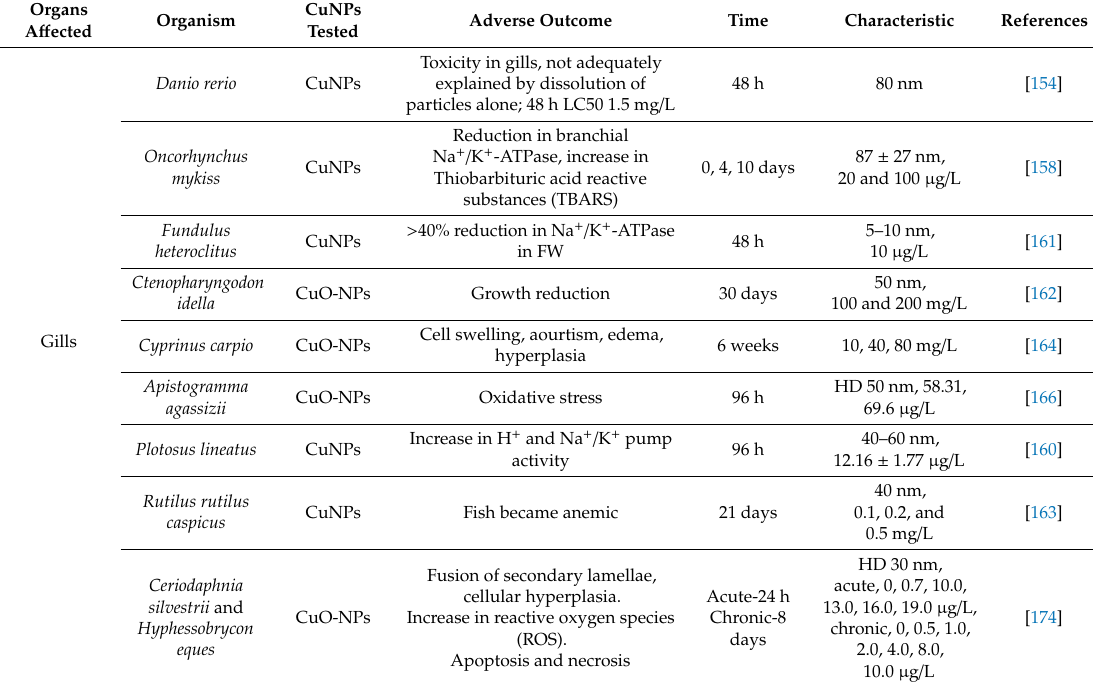
Table 2. Summary of copper nanoparticle toxicity in fish based on target